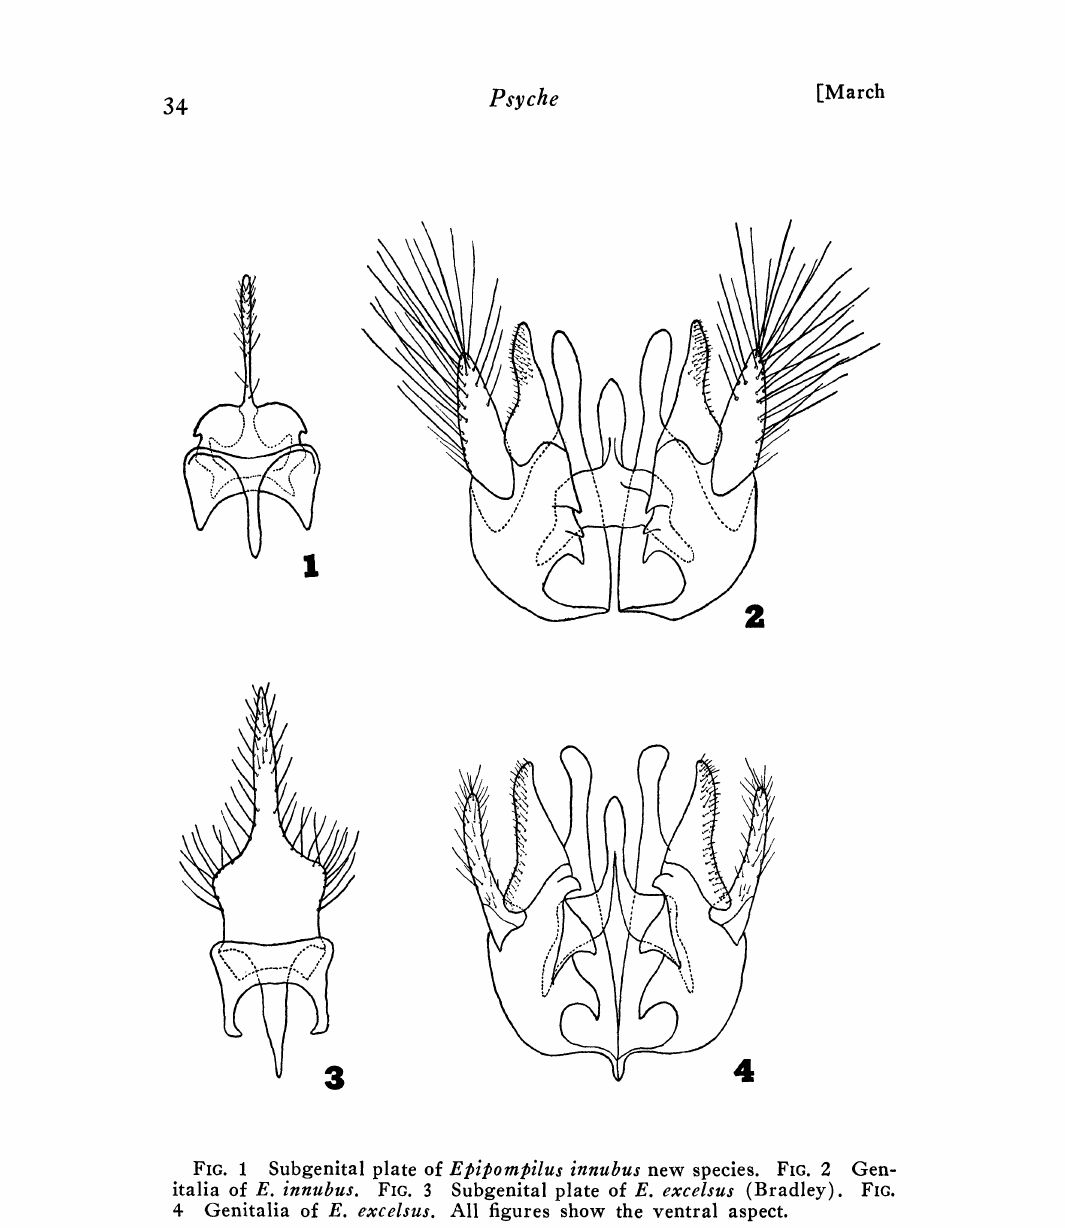
F. Subgenital plate of Epipompilus innubus new species. FG. 2 Gen- italia of E. innubus. FG. Subgenital plate of E. excelsus (Bradley). F. 4 Genitalia of E. excelsus. All figures show the ventral